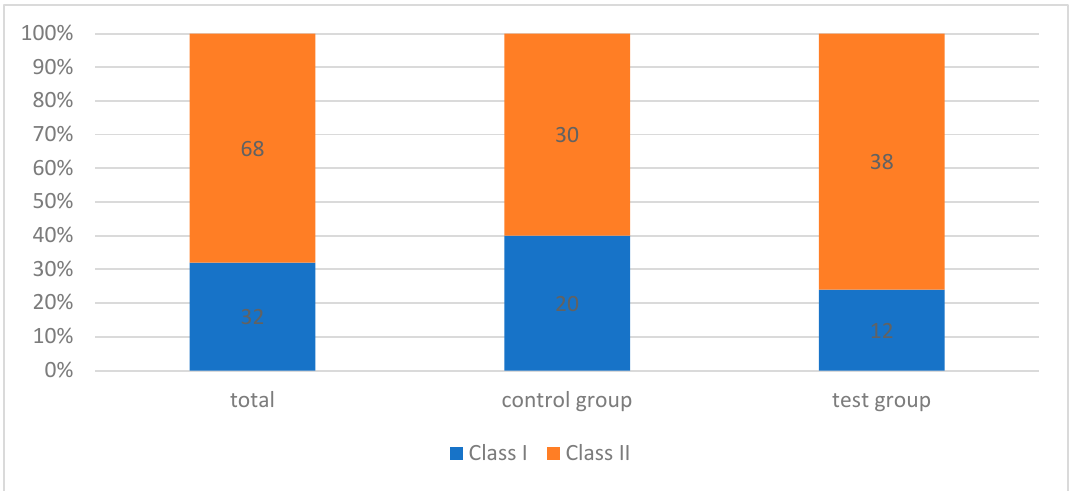
Figure 2. Black’s classification of dental lesions included in the study. Of the total 42 premolars, 22 teeth and, of the total 58 molars, 28 cavities were assigned to the control group (Figure 3).